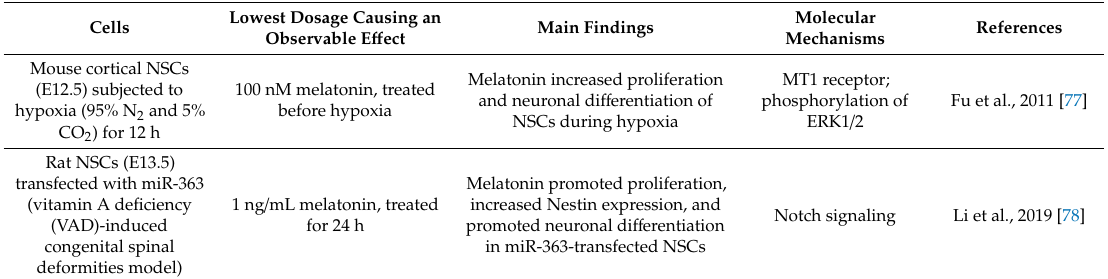
Table 7. Table showing the main findings regarding the e ff ects of melatonin on neurogenesis in CNS injuries and the respective molecular mechanisms in the in vitro